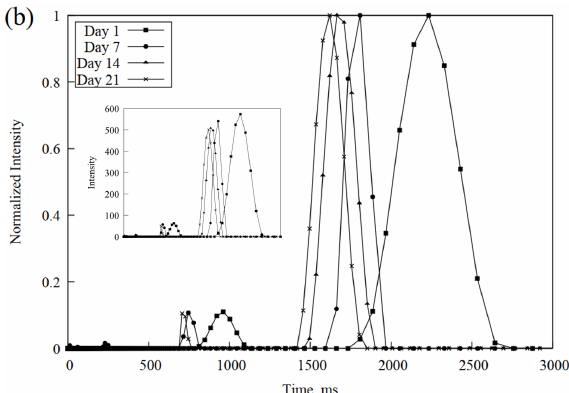
Figure 7. Relaxation time distribution (T 2 ) of glass beads saturated with 1% Na 2 SO 4 : ( a ) Untreated glass beads aged for 21 days at 25 ◦ C; ( b ) Treated glass beads aged for 21 days at 25 ◦ C. Inset plots correspond to non-normalized